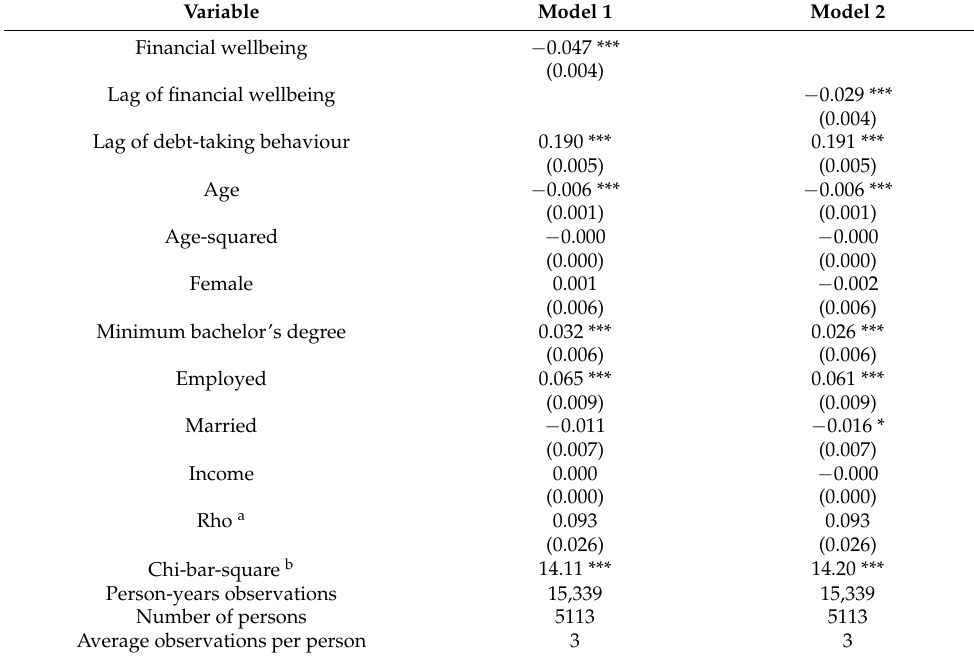
Table 8. Results of the pooled regression